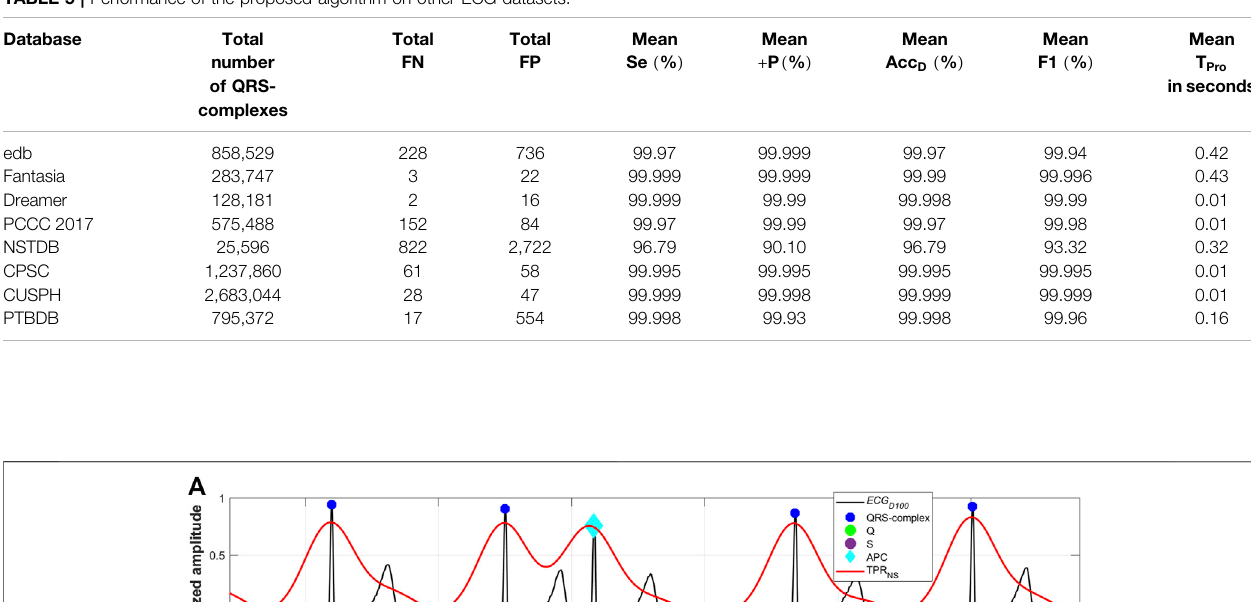
TABLE 5 | Performance of the proposed algorithm on other ECG datasets.